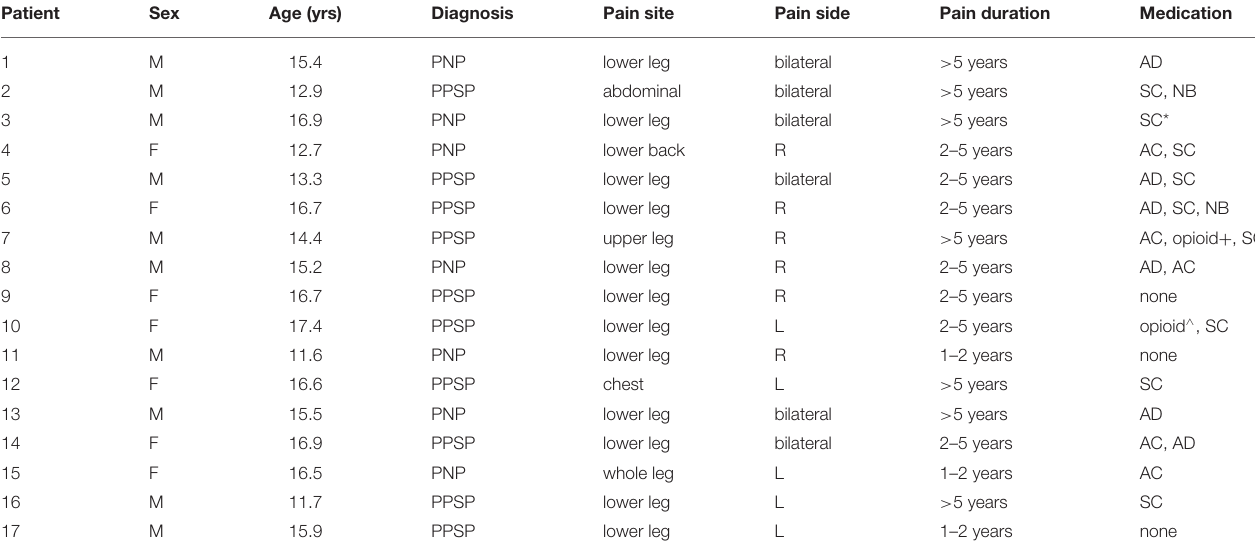
TABLE 1 | Demographic characteristics of included participants with NeuP.